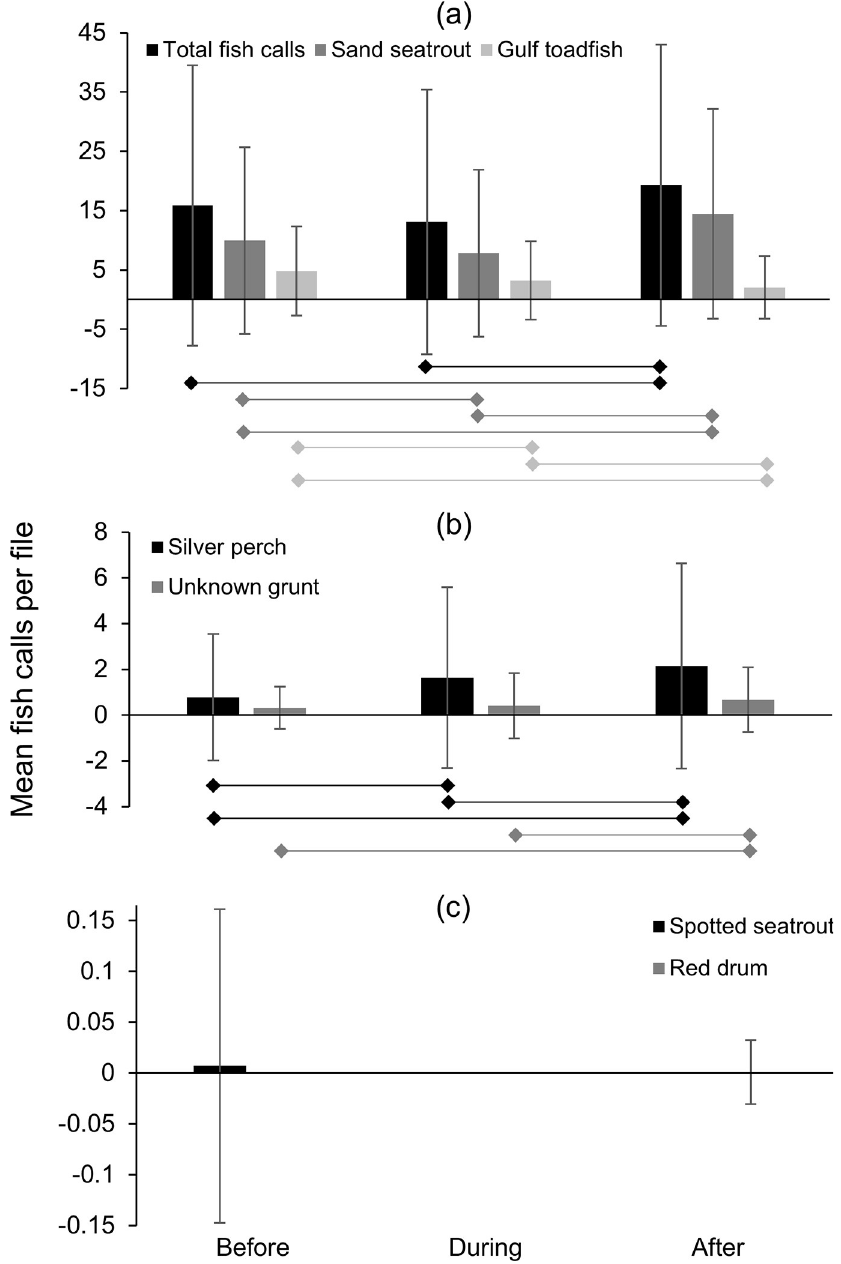
Fig 8. Mean fish detections per file at station Boca 3 during Tropical Storm Debby. Mean number of fish calls detected per acoustic file before, during and after the passage of Tropical Storm Debby at station Boca 3 (inshore); (a) total fish calls (all species), sand seatrout calls and gulf toadfish calls, (b) silver perch, unknown grunt, (c) spotted seatrout, red drum. Bars beneath plots indicate significant differences in post-hoc tests (p < 0.05). Note in (c) that spotted seatrout calls were only observed before the storm, and a single red drum call was observed after the storm.